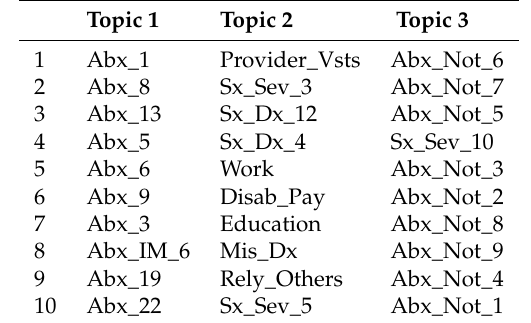
Table 4. Results of SSNMF with three topics on MLD. We display the ten topic features with highest magnitude in the topic (note that all features contribute positively to the topic).